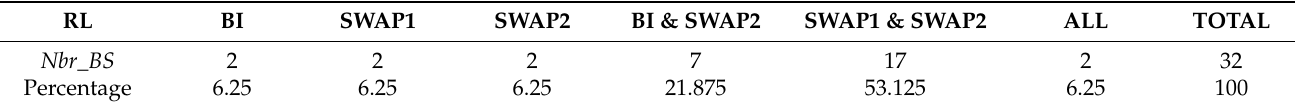
Table 16. Breakdown of the best solutions by